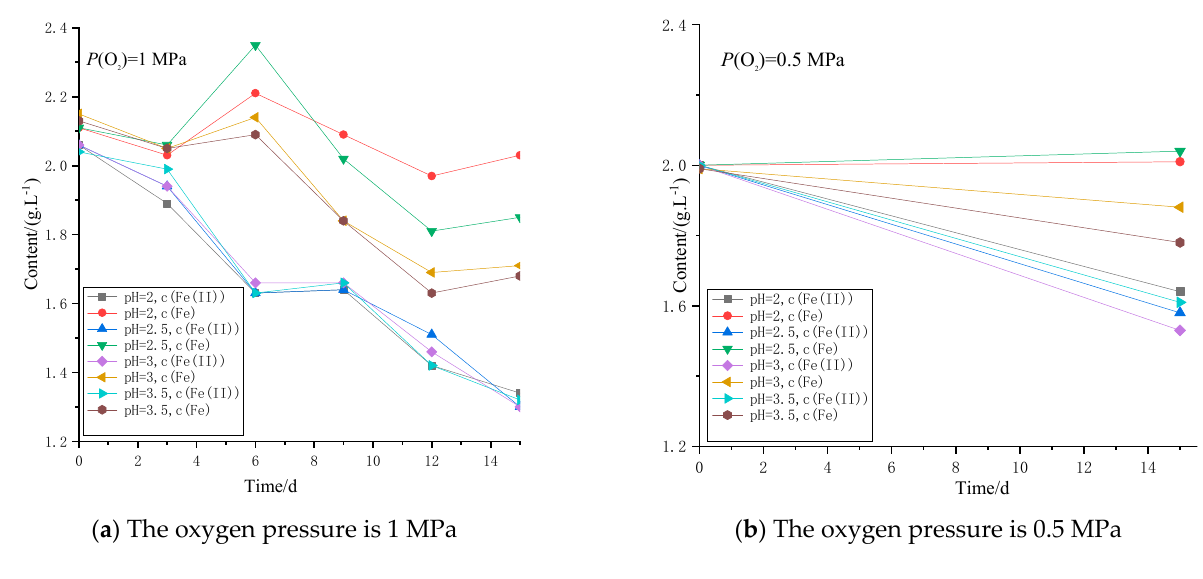
Figure 2. Oxidizing effect of oxidant on Fe(II) under different pH conditions.( a ) shows the use of hydrogen peroxide. ( b ) shows the use of oxygen.